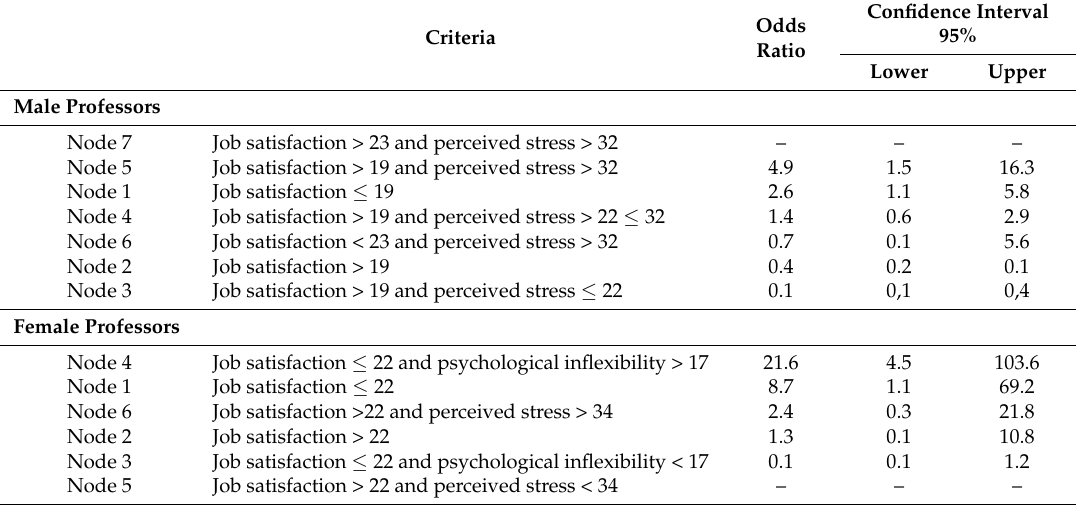
Table 4. Odds Ratio for problematic alcohol consumption in male and female professors from higher to